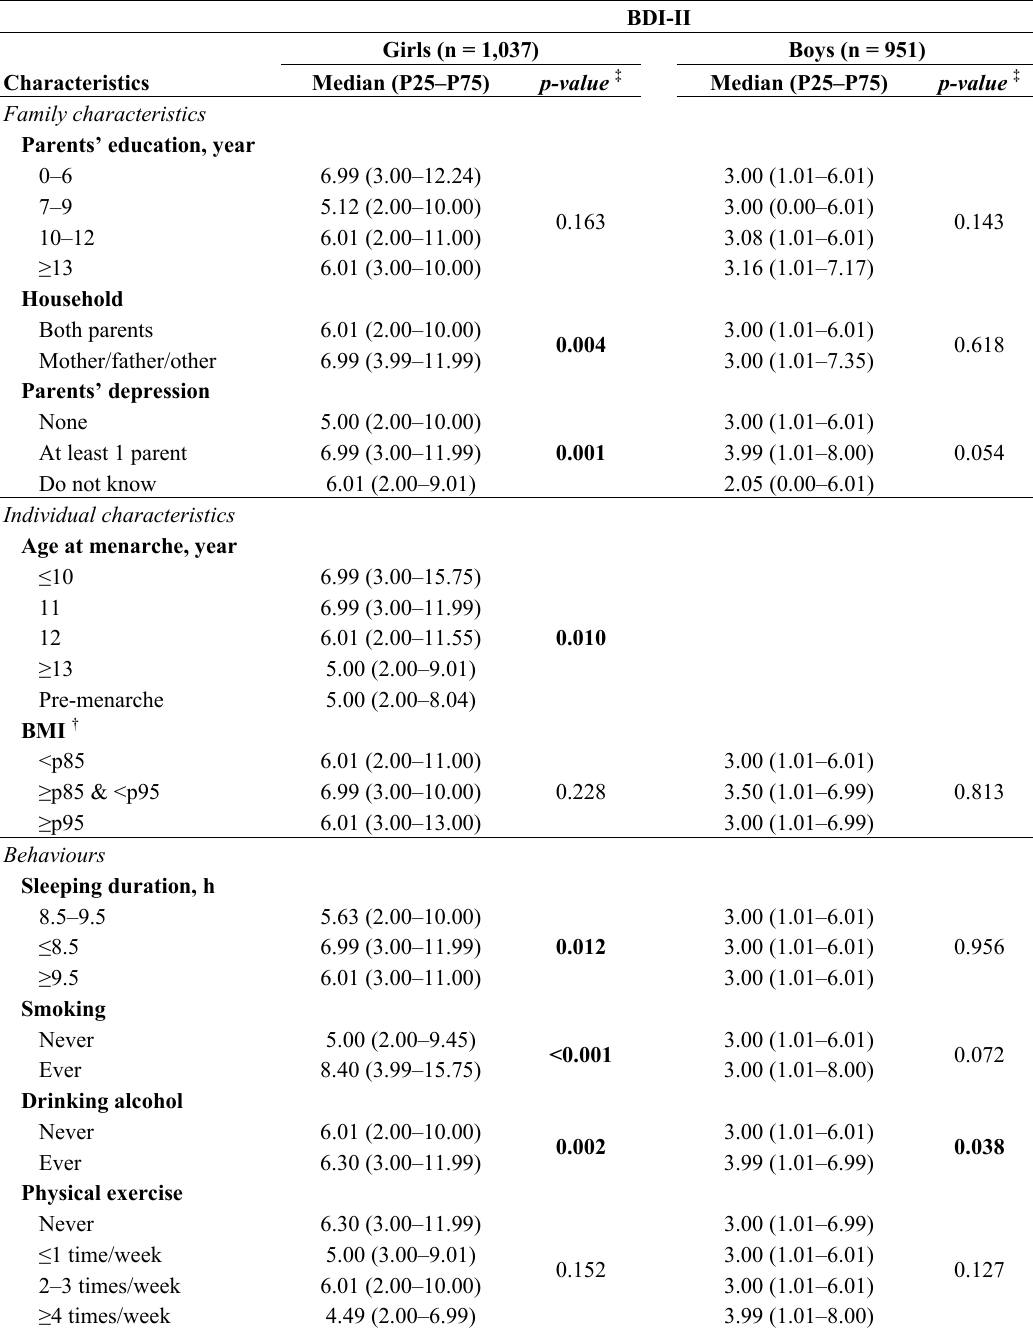
Table 1. Beck Depression Inventory scores (median and P25–P75) according adolescents’ characteristics, by sex (Porto, Portugal 2003–2004) (n =